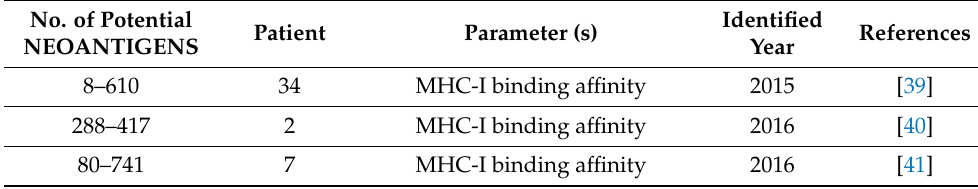
Table 1. Potential neoantigens identified in lung